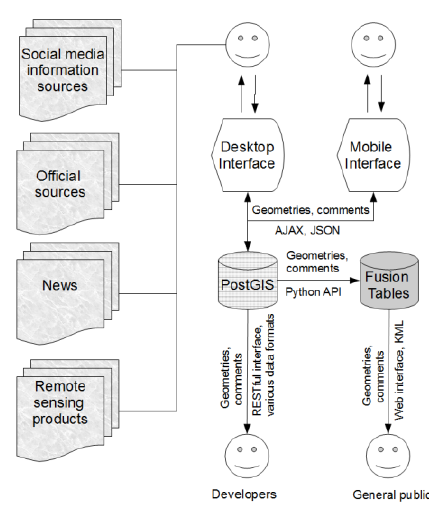
Figure 2. The system's components. Data streams are represented by arrows. The users on top are the data collectors. They gather data and enter it through the desktop and mobile interfaces. The text on top and left of the lines denote the payload of the data stream while the text on the bottom and right of the lines denotes the used